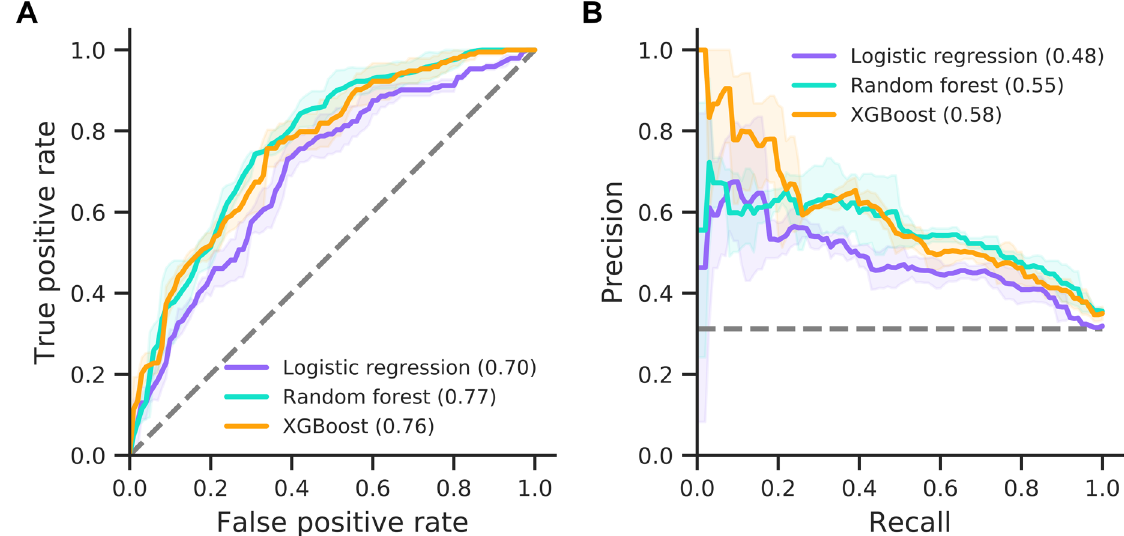
Figure 6. Prediction performance for mortality. Model performances for the logistic regression, random forest and XGBoost models are shown as ROC ( A ) and precision-recall curves ( B ). AUC is provided in brackets. Solid lines and shaded areas indicate the mean and standard deviation across three cross-validation folds, respectively. Dashed lines indicate random